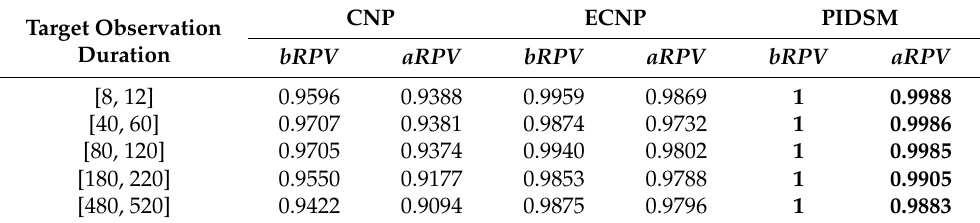
Table 10. Comparison results of different target observation durations.